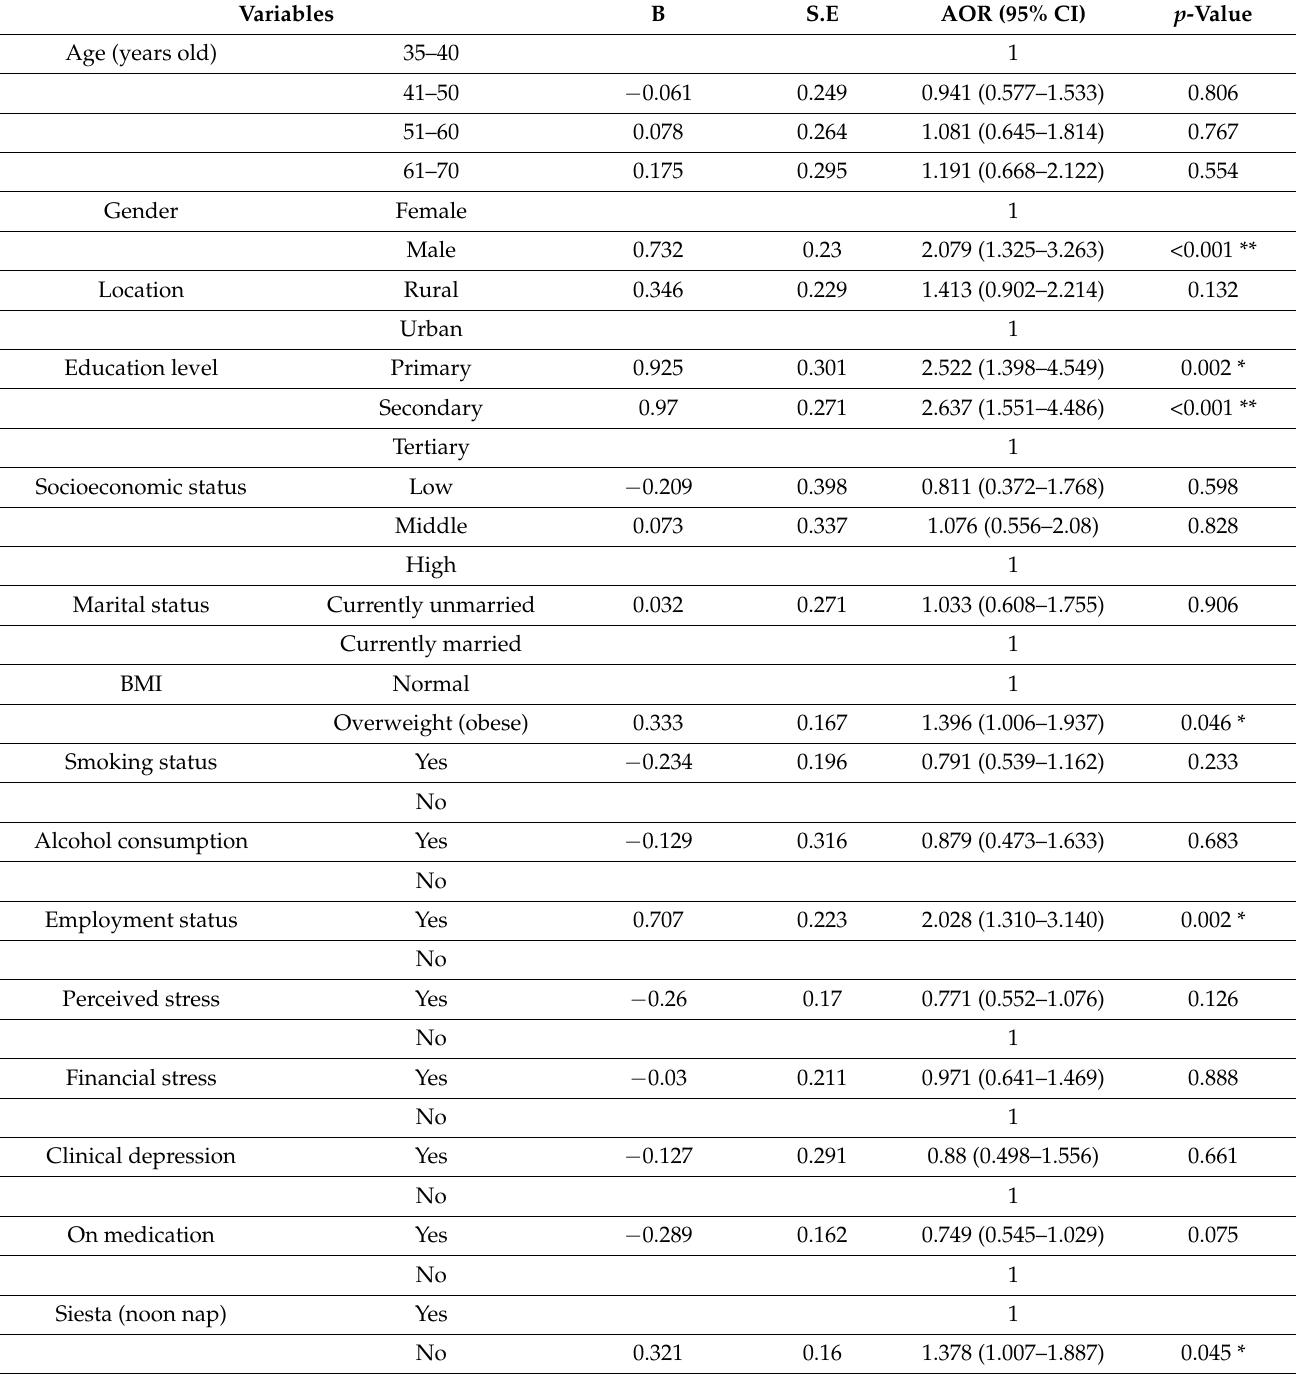
Table 2. Factors associated with road traffic accidents ( n =